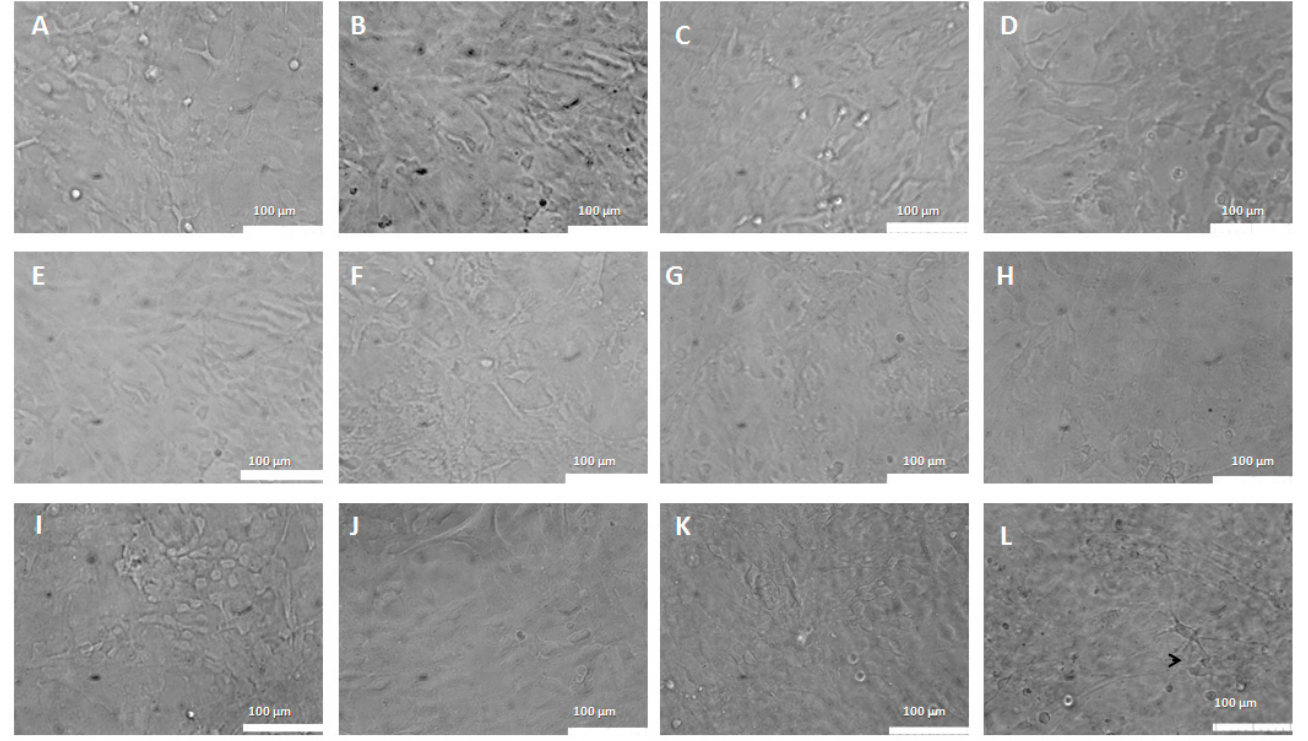
Figure 10. Morphological aspects of astrocytes treated with CP-loaded PEGylated liposomes (0.2–30 μ g/mL). Astrocytes treated with copaiba oil in PEGylated liposomes at various doses. ( A )—Control: Astrocytes in DMEM medium. ( B )—with 0.5% of empty liposomes. ( C )—0.2 μ g/mL; ( D )—0.3 μ g/mL. ( E )—0.6 μ g/mL. ( F )—1 μ g/mL. ( G )—2 μ g/mL. ( H ) =3 μ g/mL. ( I )—6 μ g/mL. ( J ) =10 μ g/mL. ( K )—20 μ g/mL. ( L )—30 μ g/mL. Confocal microscopy, 100 μ m bar.